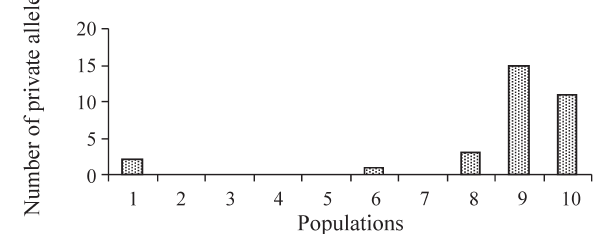
Figure 3 - Correlation (r) between the geographic distance matrix and the genetic distance matrix obtained by SSR